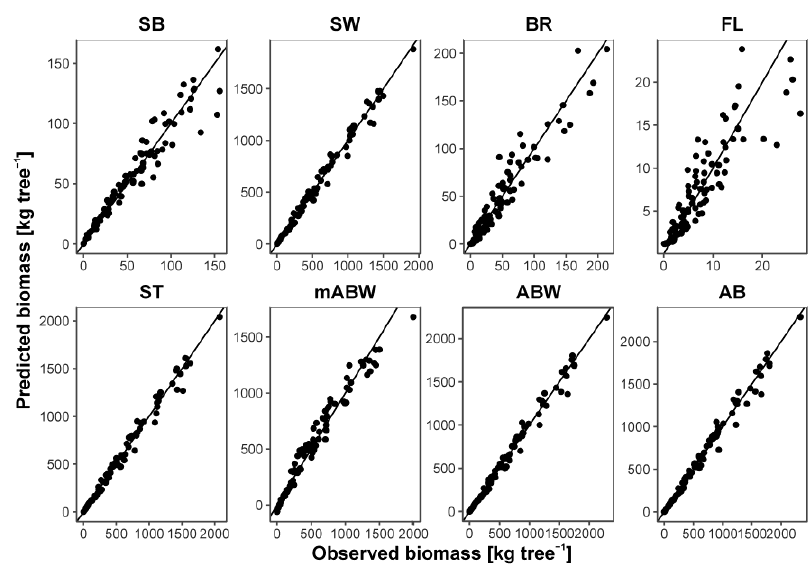
Figure 1. Goodness of fit of generalized allometric equations for biomass components developed using